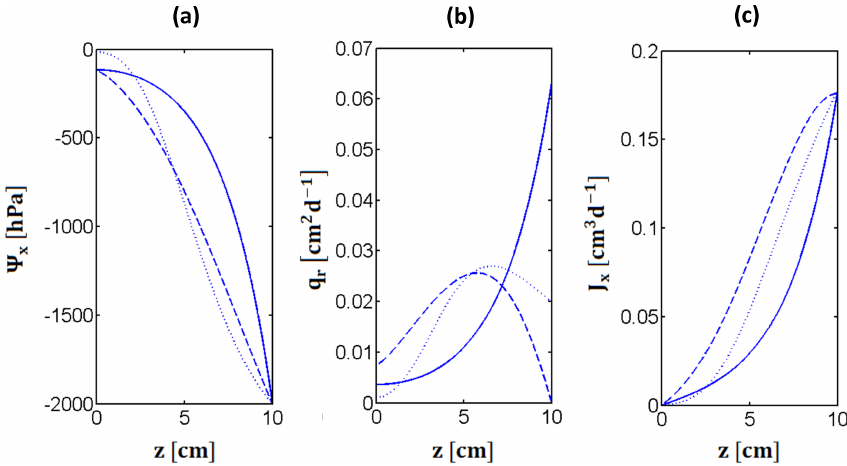
Figure 5. Solutions of the root water flow equation: xylem water potential (a) , radial water flow per root length (b) and axial water flow (c) along a root with constant properties (solid blue line), a root with linear hydraulic profiles (dashed lines) and a root with exponential hydraulic profiles (dotted lines). The origin of the z axis is at the root